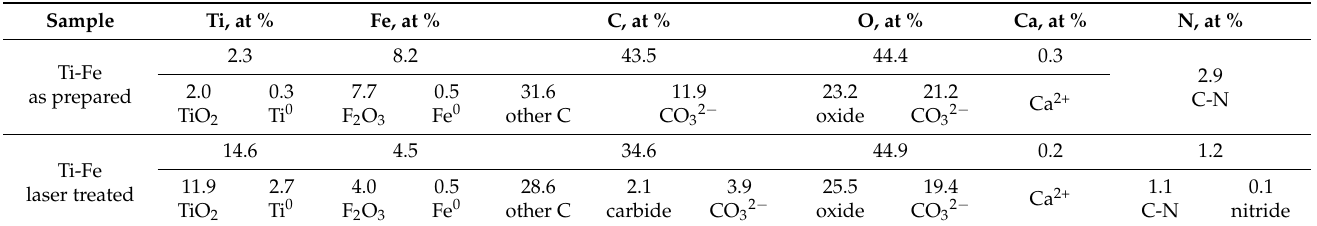
Table 1. Surface element analysis evaluated with XPS.